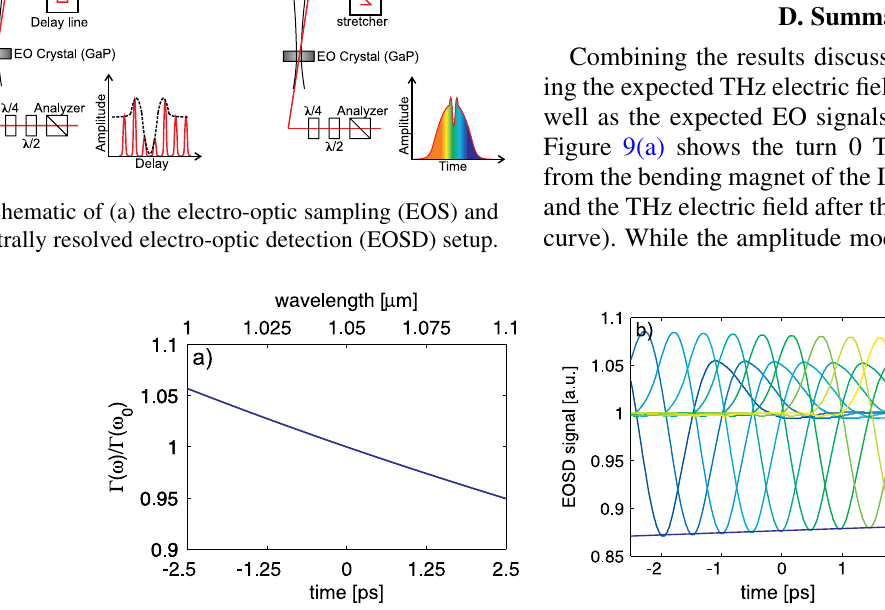
FIG. 8. (a) In EOSD experiments the probe wavelength dependent sensitivity translates into a delay dependent sensitivity. (b) Simulated EOSD signals for ten different relative arrival times.